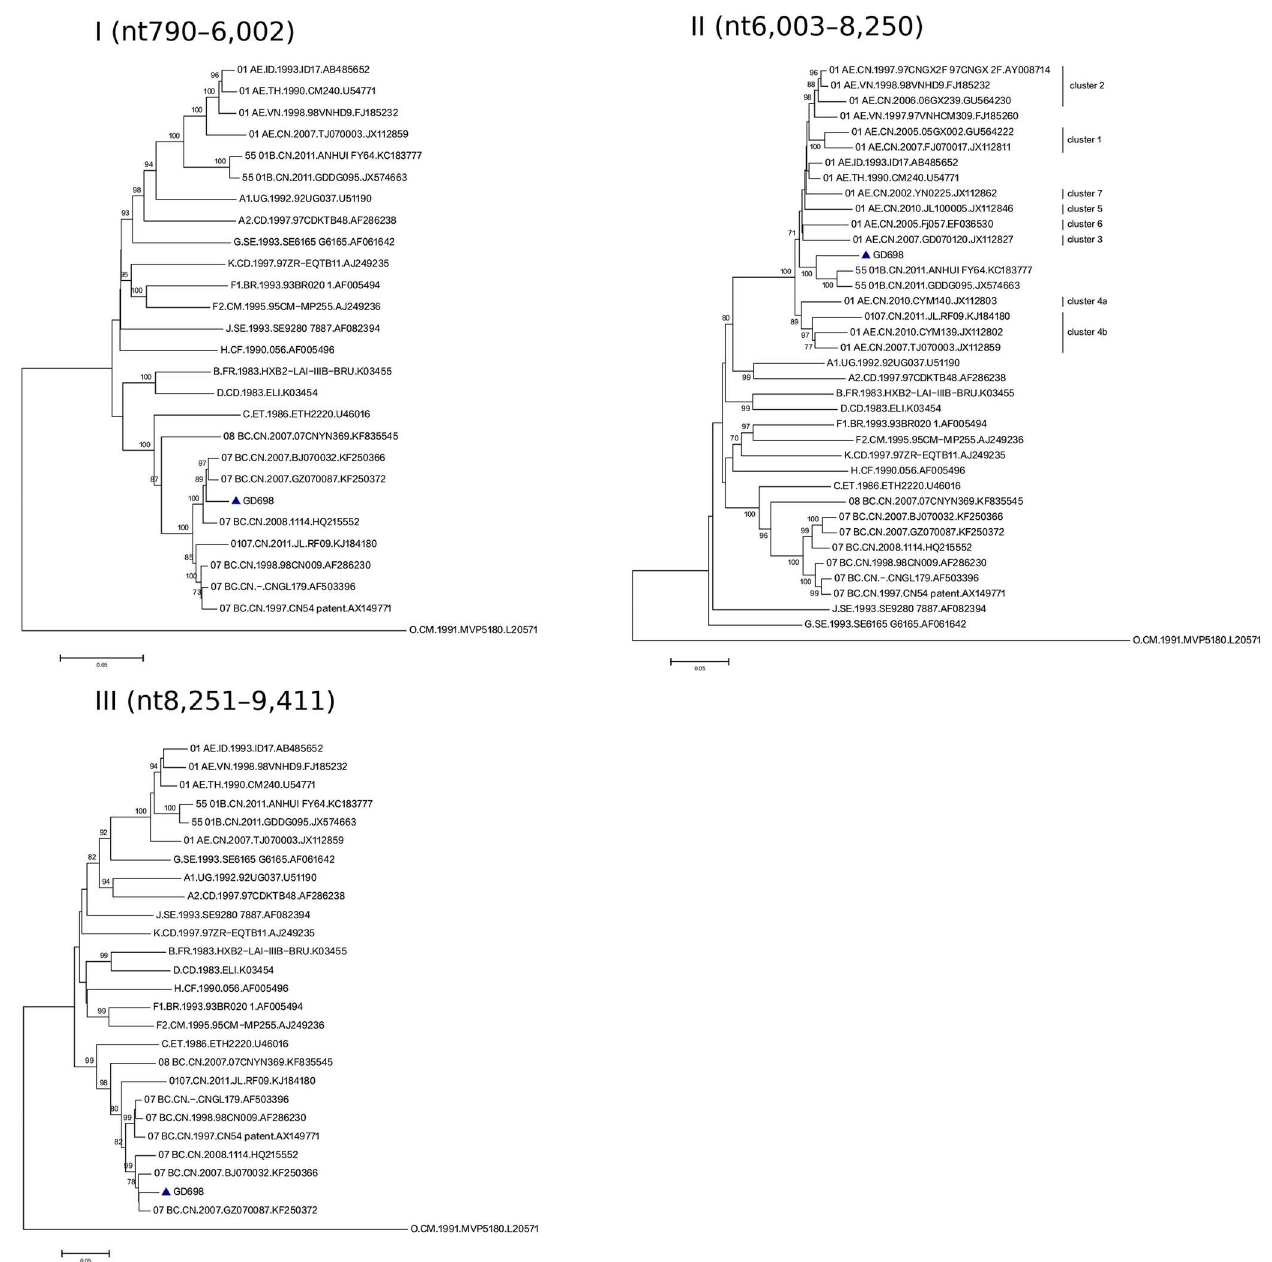
Fig 3. Phylogenetic analysis of GD698 regional segments. Regionsof the sequencealignment were extracted accordingto the indicated breakpoints. Each segment was analyzedseparately with the phylogenetic neighbor-joiningmethod with the bootstrapvalue of > 70%. Representative trees are illustratedfor regions I through III. Loci of genomicsegments are basedon the HXB2 numbering engine.The genetic distancecorresponding to the lengths of the branchesis shown by the bottom line.